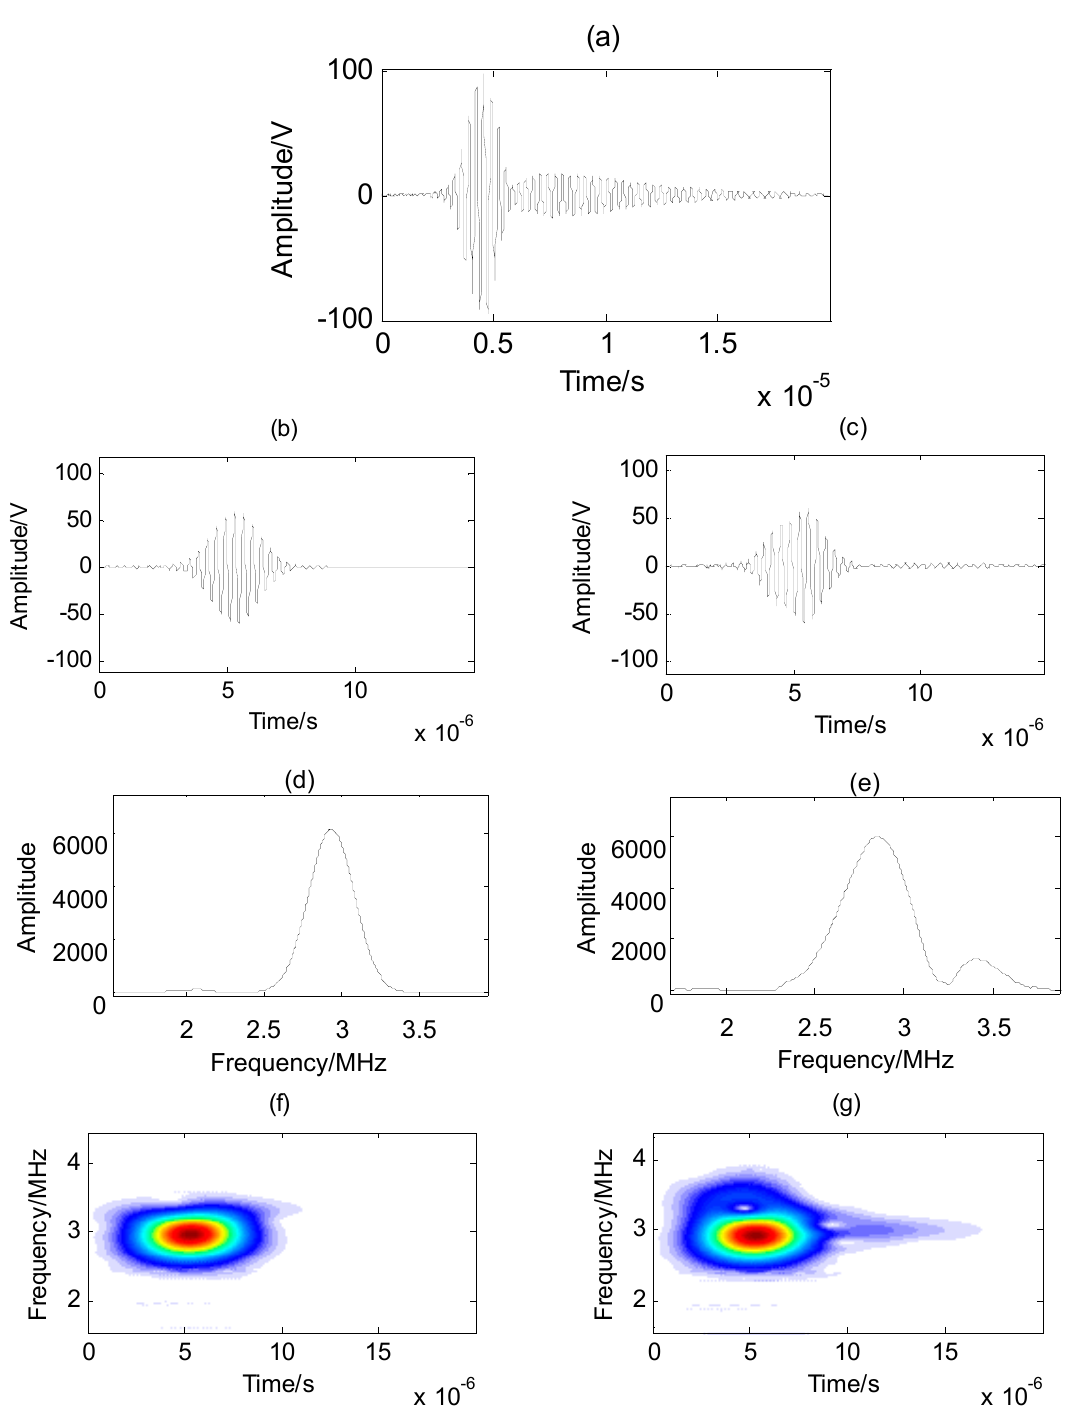
Figure 4. ( a ) The compensated multimodal Lamb wave signal at the distance of 2.7 cm; ( b ) separated A 1 mode time domain waveform using the proposed method; ( c ) separated A 1 mode time domain waveform using the time-frequency blind signal separation method; ( d ) amplitude spectrum of A 1 mode separated using the proposed method; ( e ) amplitude spectrum of A 1 mode separated using the time-frequency blind signal separation method; ( f ) time-frequency distribution of A 1 mode separated using the proposed method; ( g ) time-frequency distribution of A 1 mode separated using the time-frequency blind signal separation